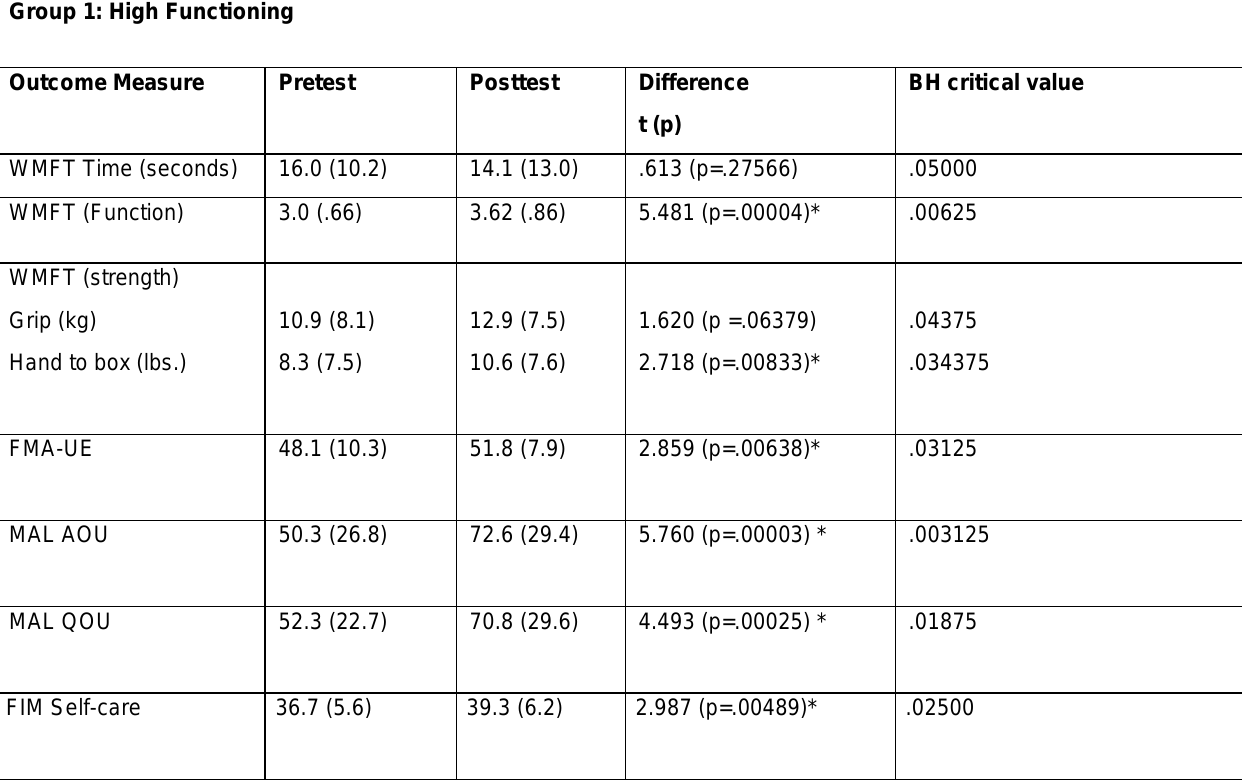
Table 3. Pre and Post